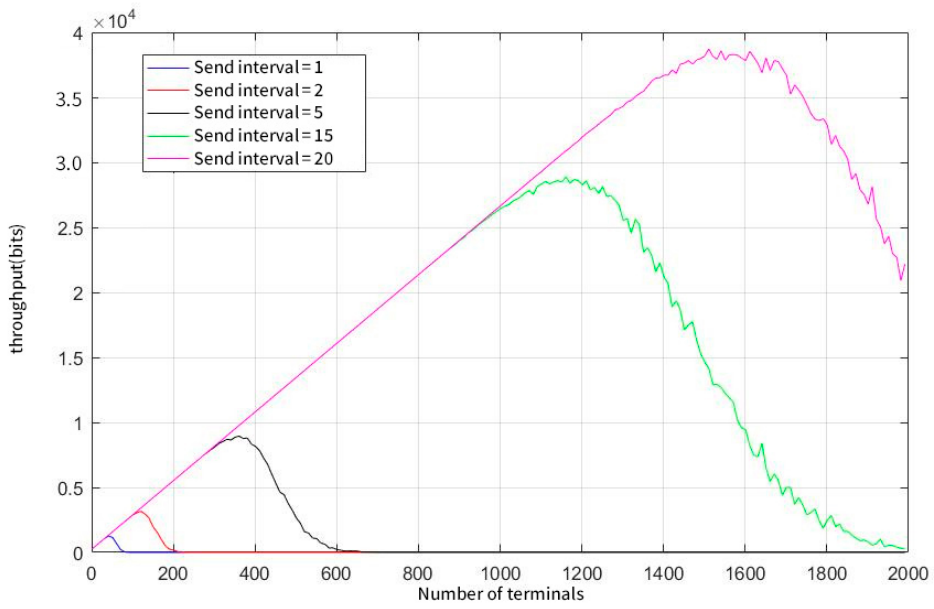
Figure 11. System throughput at a concurrent demodulation threshold of 50.